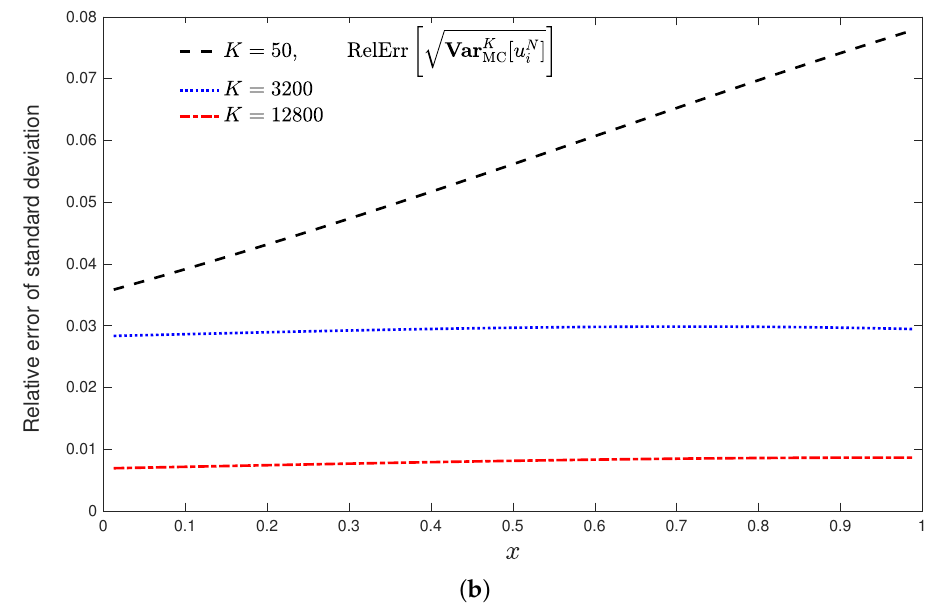
( b ) ] , (56). Plot ( b ): Relative errors [ u N Figure 2. Plot ( a ): Relative errors of the approximations to the expectation (mean), E K MC i (cid:113) [ u N ] , (57). For both graphics the fixed time horizon is T = 1 = Nk of the approximations to the standard deviation, Var K MC i with the temporal step-size k = 0.0001 ( N = 10,000), the spatial domain x i ∈ [ 0 + h ,1 − h ] with x i = ih , h = 0.0125, but varying the number of MC simulations K ∈ {50, 3200, 12,800}. Table 2. RMSEs at T = 1 and K = 1600 (MC simulations) for the expectation (54) and the standard deviation (55). The considered step-sizes h and k verify stability conditions (21) and (23). T = Nk = 1, N ∈ { 125,500,2000,8000 } , the spatial domain is [ 0 + h ,1 − h ] considering M − 1 internal points x i = ih , 1 ≤ i ≤ M − 1 with M = 1/ h .